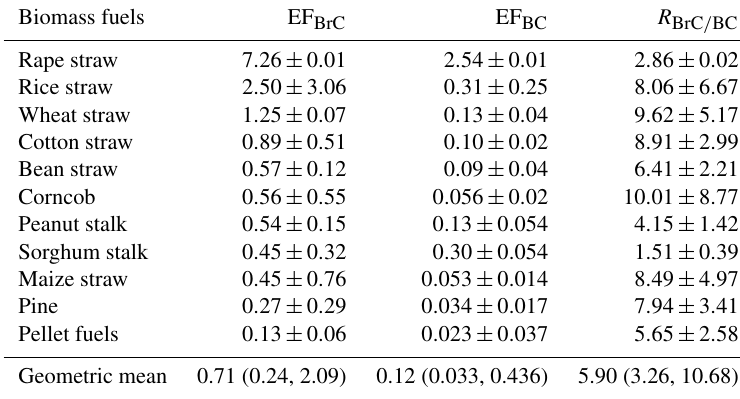
Table 1. Measured EF BrC and EF BC (gkg − 1 ) values for household biomass burning.